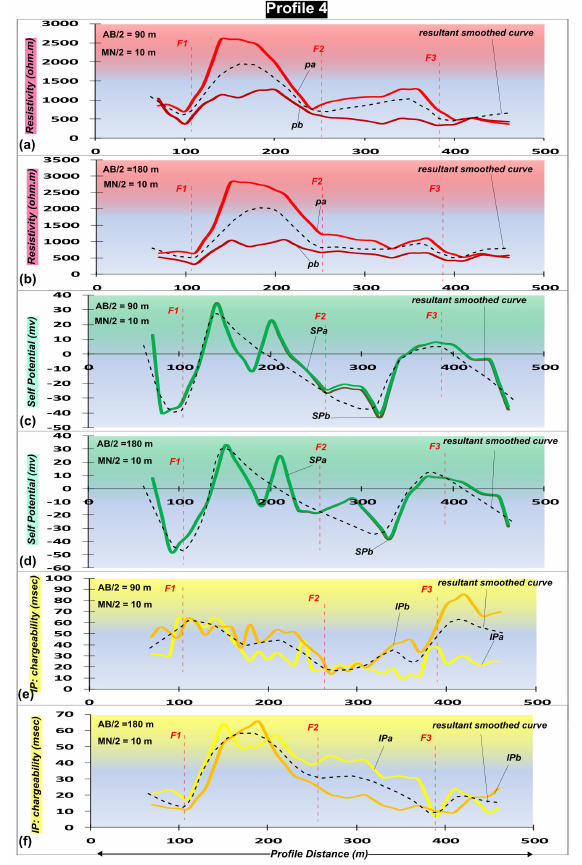
Figure 13. Graphical plots of Joint Profile Method (cross-sectional) along profile 4 for ( a , b ) resistivity ( c , d ) self potential and ( e , f ) induced